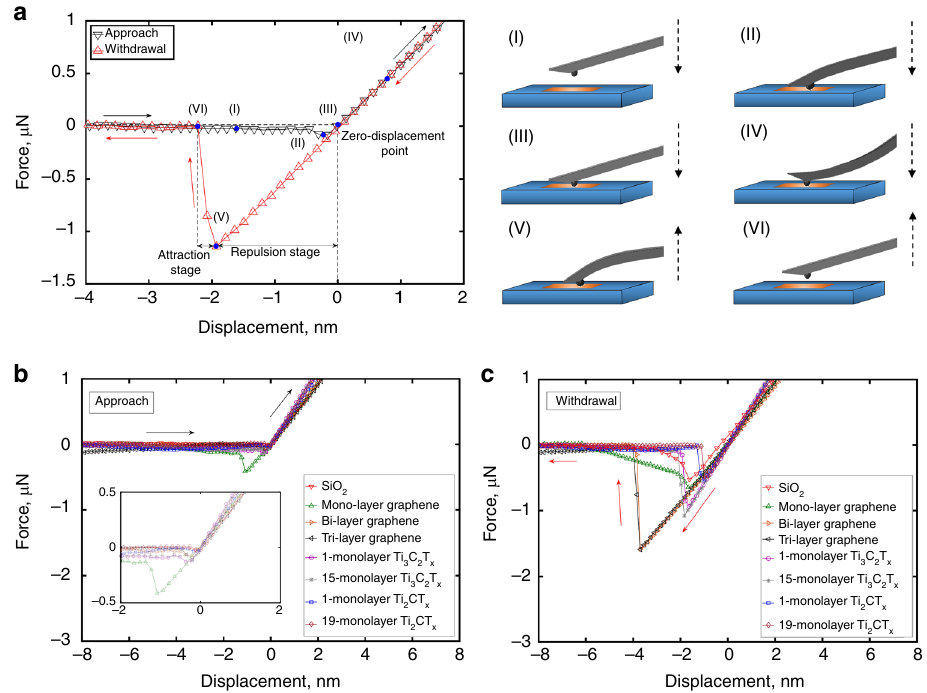
Fig. 3 Force versus displacement graphs: a approach and withdrawal for 5-monolayer Ti 3 C 2 T x sample and cartoons illustrating relative positions of the tip and the sample during different key stages of the AFM indentation process, b approach, c withdrawal for different